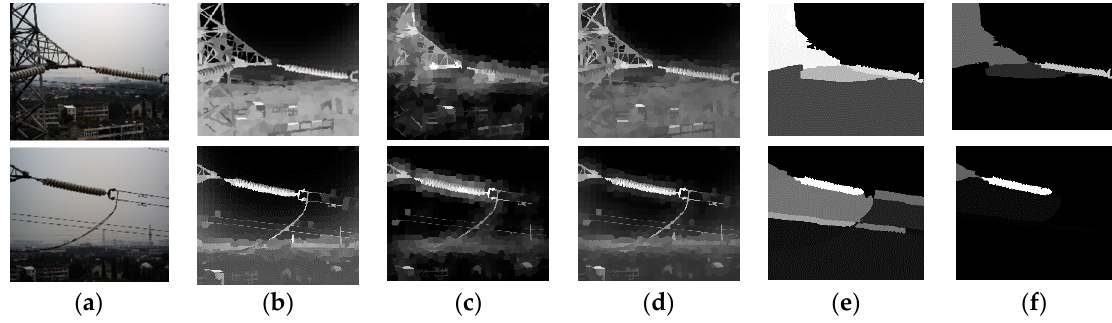
Figure 5. Feature contrast maps: ( a ) input images; ( b ) color contrast; ( c ) texture contrast; ( d ) 2D visual saliency maps; ( e ) depth maps; ( f ) RGB-D saliency maps.